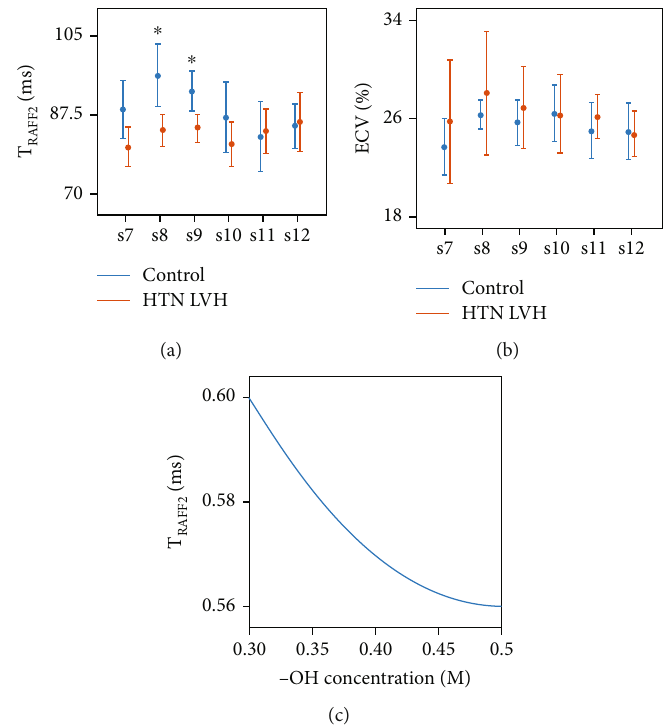
Figure 3: Segment-wise, segments 7 – 12, (s7-s12), characteristics of HTN LVH patients, and control group given as error bars of (Student ’ s t -test) RAFF2 relaxation time (a), ECV (b), and T Bloch-McConnell simulation RAFF2